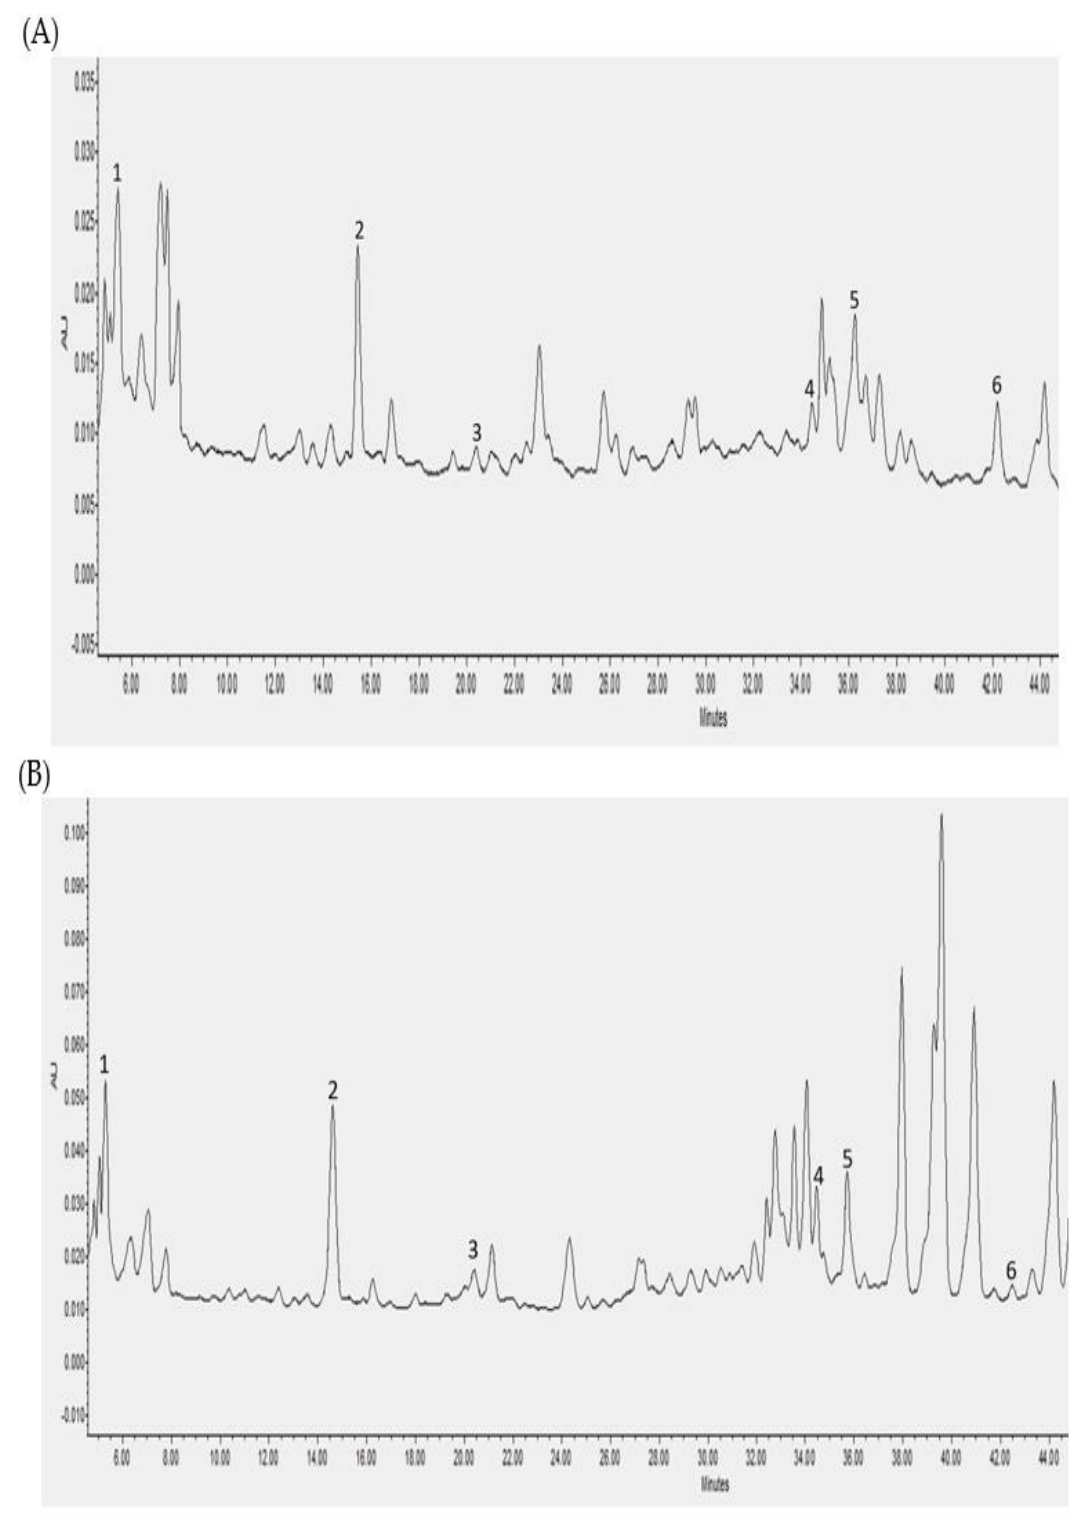
Figure 3. HPLC chromatograms of gastrointestinal fractions of lucerne; ( A ) Soluble gastric fraction (extracted from supernatant), ( B ) Soluble intestinal fraction (extracted from supernatant). Polyphenols identified are (1) Gallic acid, (2) Catechin, (3) Epicatechin, (4) Epicatechin gallate, (5) Quercetin-3-galactoside, (6) Kaempferol-3-glucoside.